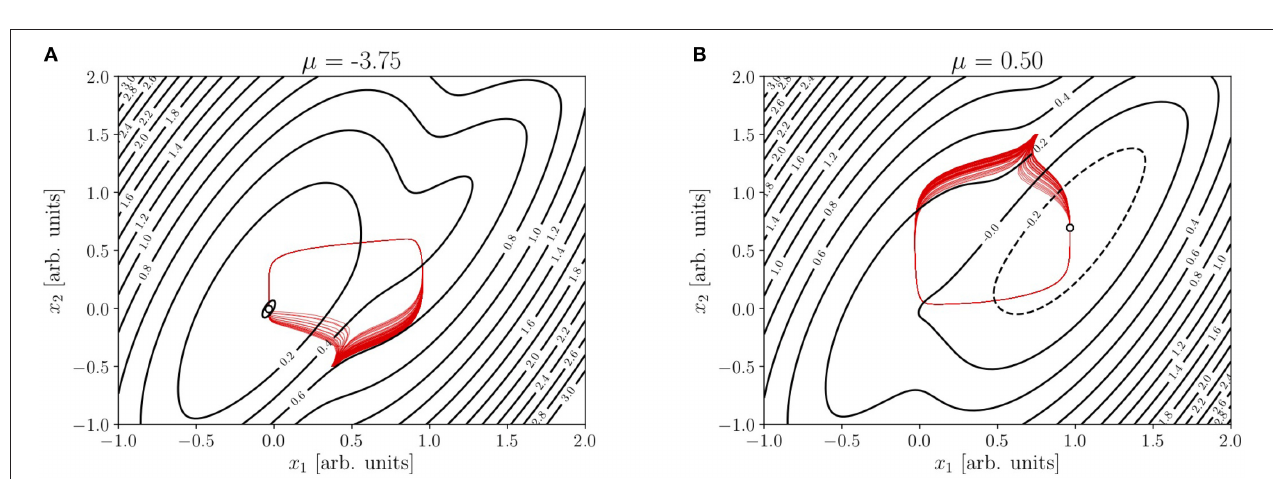
FIGURE 2 | (A) Abscissas (solid line) and ordinates (dashed line) of the “off” (circle) and “on” (cross) nodes of Equations (4)–(5) (with r 1 (B) Trajectories from random initial conditions and contour plot of the NEP—Equation (8), with S k ( i k ) µ 1 1.7 (B) , and near the “off” (C) , and “on” (D) saddle-node bifurcations. Remaining parameters: ρ = − j 21 13, j 22 11, β 1 1.2, i 0 1 2.8, β 2 1, and i 0 2 4. = = = = = =